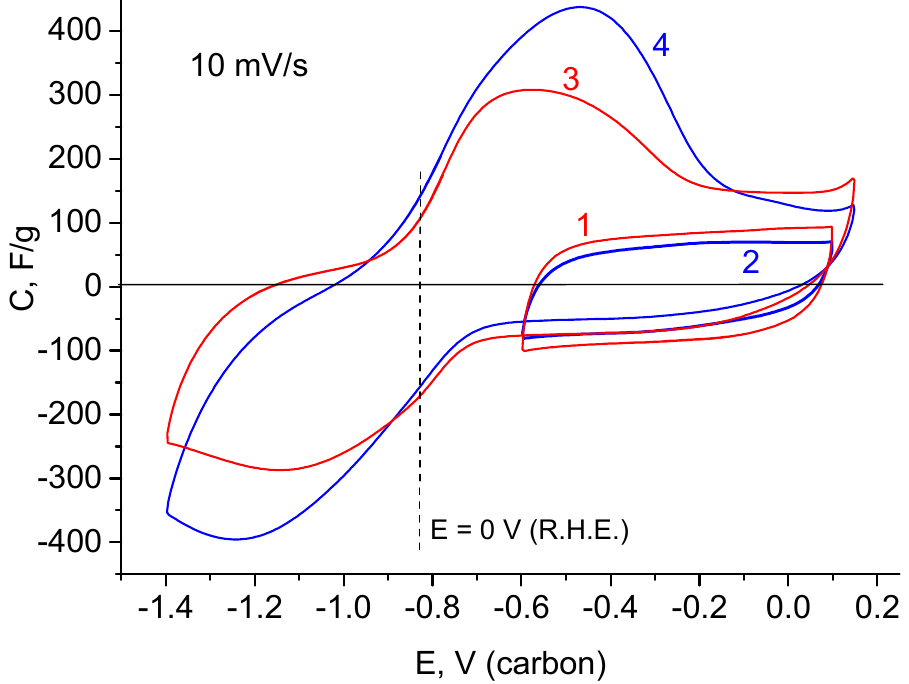
Figure 7. CVF curves: 1—rGO/TiO 2 15% (EDL region before cathodic polarization), 2—rGO/TiO 2